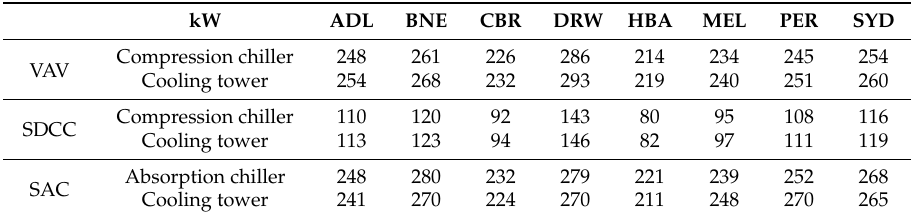
Table A1. Central plant equipment